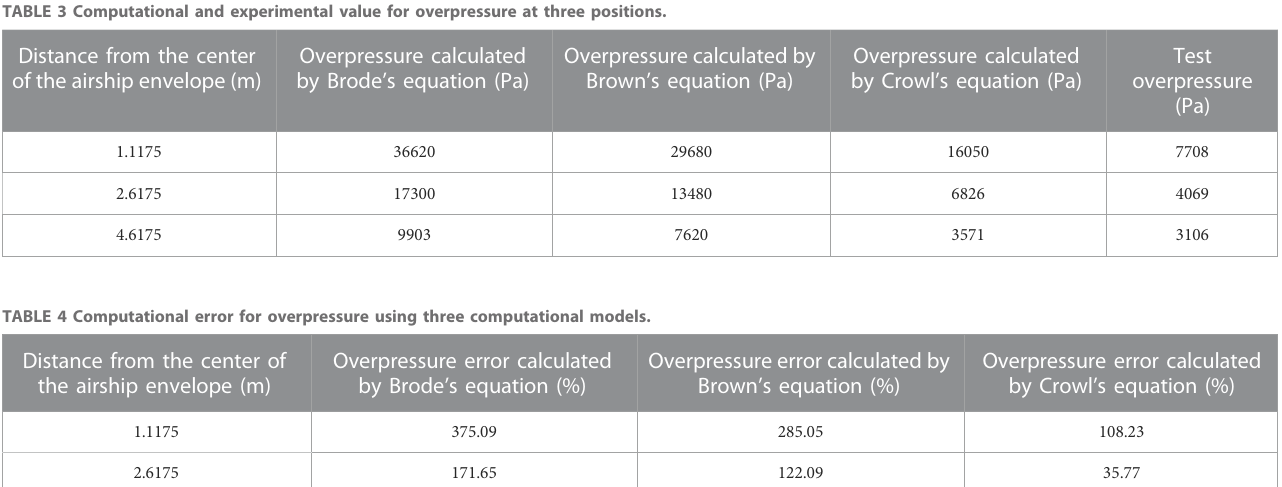
Overpressure calculated by Brode ’ s equation (Pa)